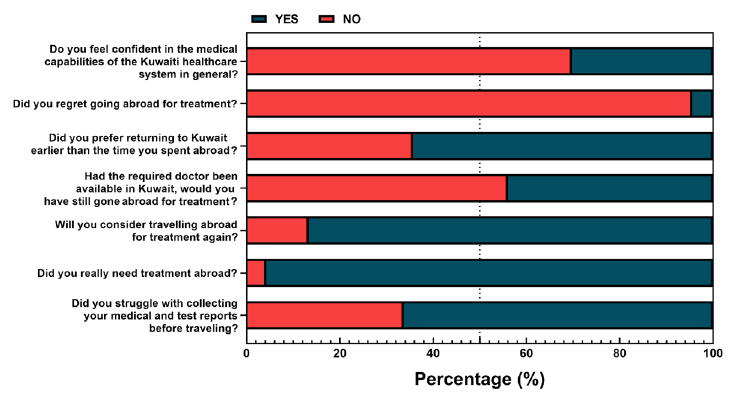
Figure 5. Responses to Yes/No Questions Related to Medical